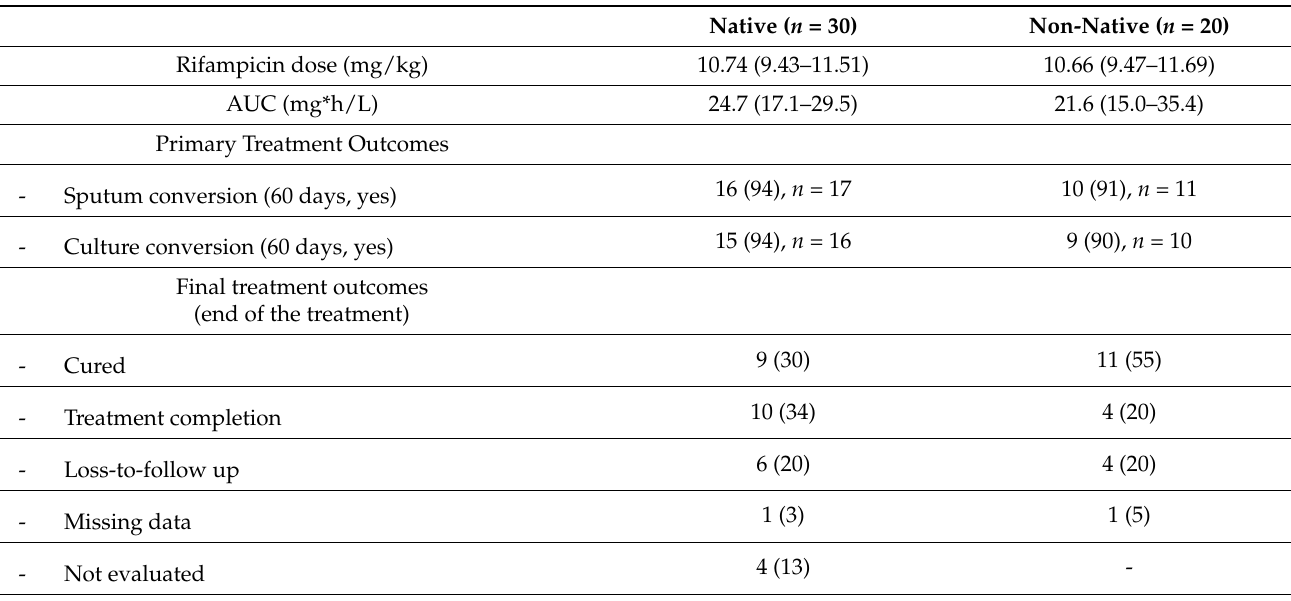
Table 2. Rifampicin dose, AUC, and treatment